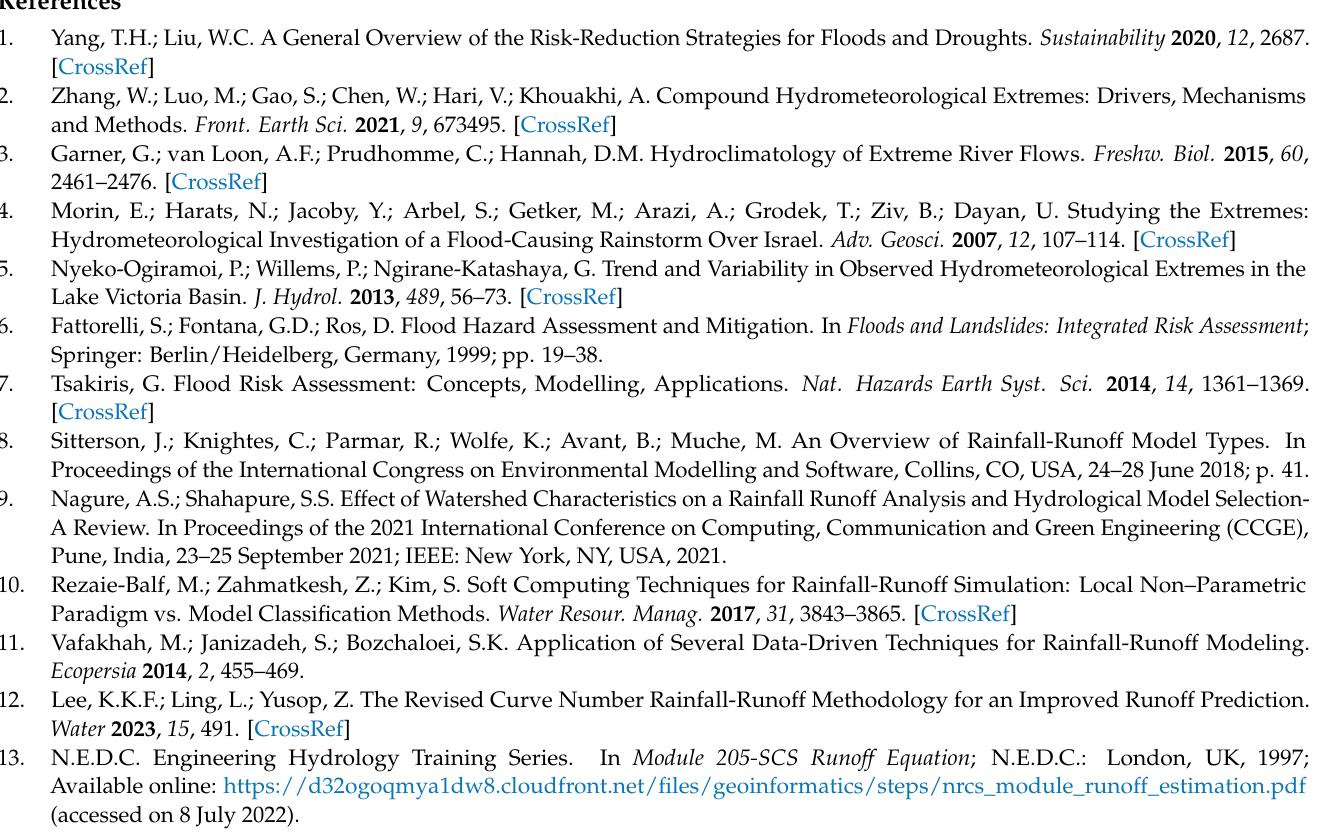
rainfall runoff model (Equation